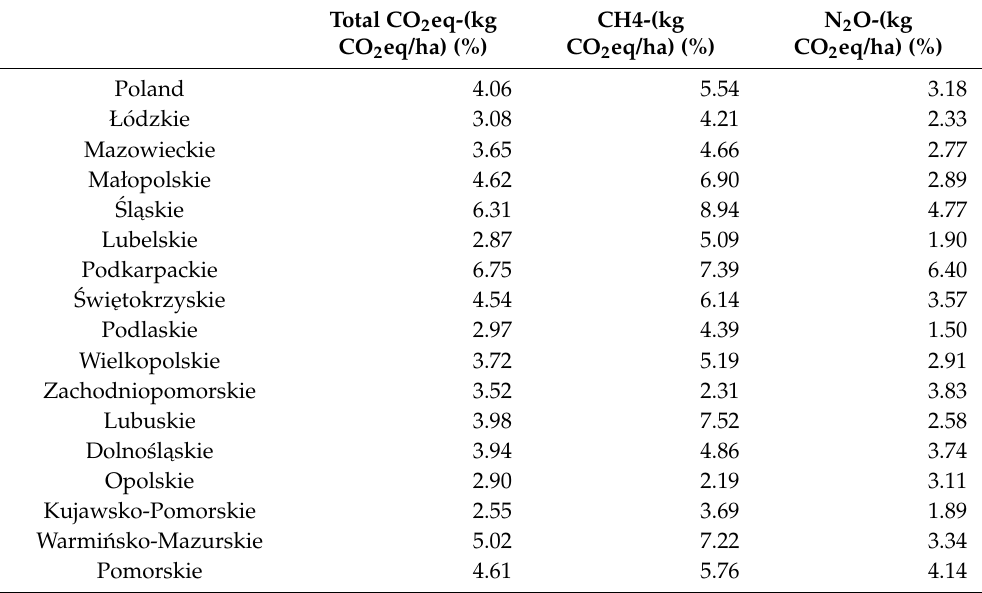
Table 3. The changes in the emission level of carbon dioxide, methane, and nitrous oxide in Polish agriculture when deleting the